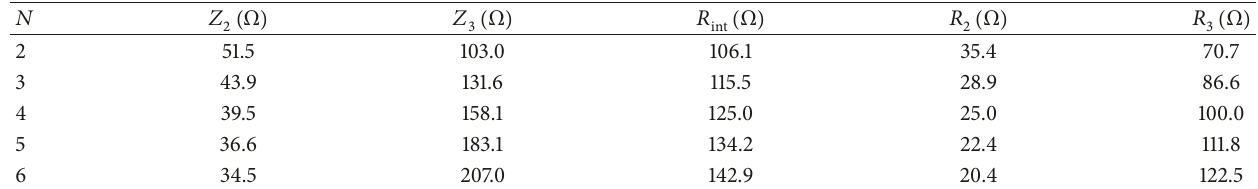
Table 1: Characteristic impedances, isolation resistances, and loads of an N : 1 unequal Wilkinson power divider.